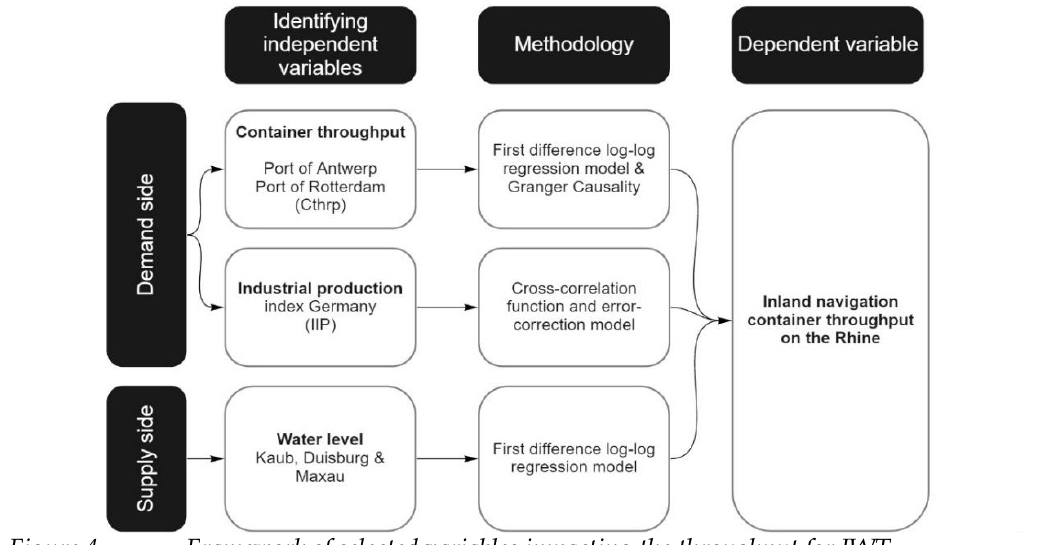
Framework of selected variables impacting the throughput for IWT Source: own composition